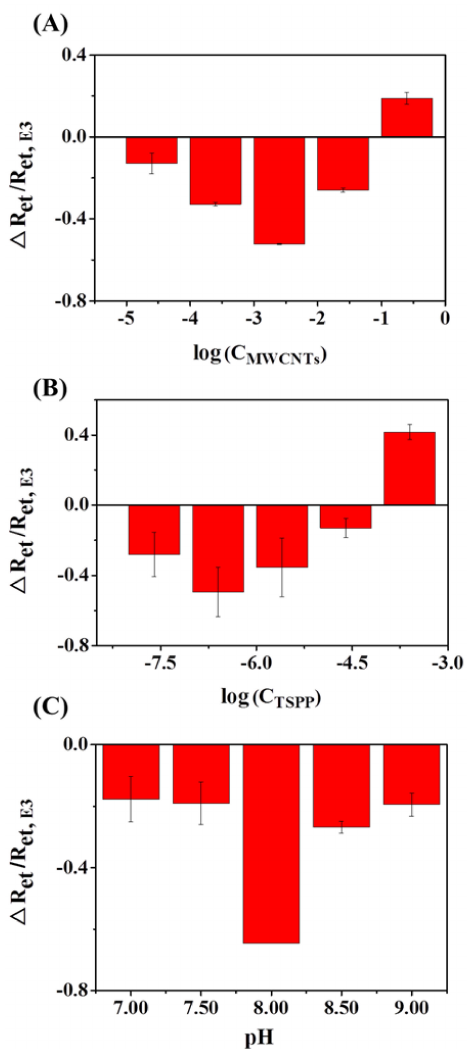
Figure 2. Effect of the concentration of MWCNTs ( A ), TSPP ( B ) solution or the pH value of TSPP solution ( C ) on the relative impedance difference ( ∆ R et /R et,E3 , herein ∆ R et = R et,E4 − R et,E3 ) in 0.05 M Tris-HCl buffer solution (pH 7.40), containing 0.005 M [Fe(CN) 6 ] 3 − /4 − and 0.20 M KCl. ( A ) The concentrations of MWCNTs solution are 2.5 × 10 − 5 , 2.5 × 10 − 4 , 2.5 × 10 − 3 , 2.5 × 10 − 2 and 2.5 × 10 − 1 g L − 1 ; ( B ) The concentrations of TSPP solution are 2.5 × 10 − 8 , 2.5 × 10 − 7 , 2.5 × 10 − 6 , 2.5 × 10 − 5 and 2.5 × 10 − 4 M; ( C ) The pH values of TSPP solution are 7.00, 7.50, 8.00, 8.50 and